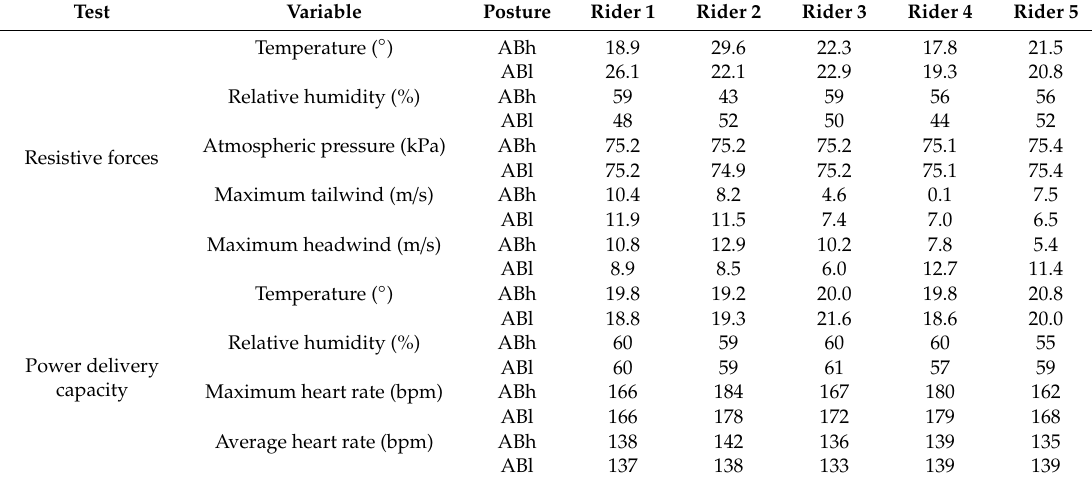
Table 5. Environmental conditions and heart rate registered during characterization